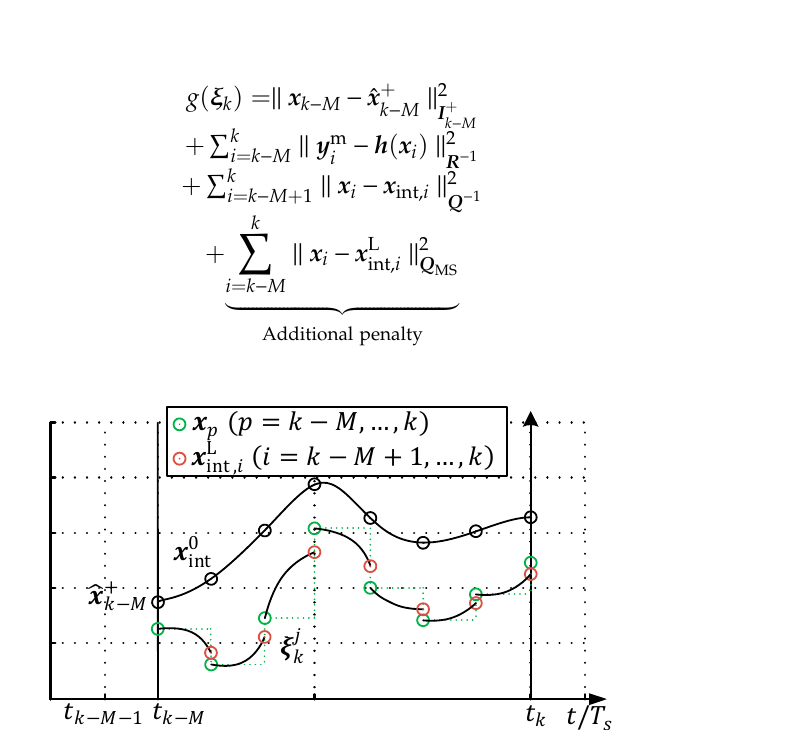
Algorithm 4. Multiple shooting MHE gradient calculation